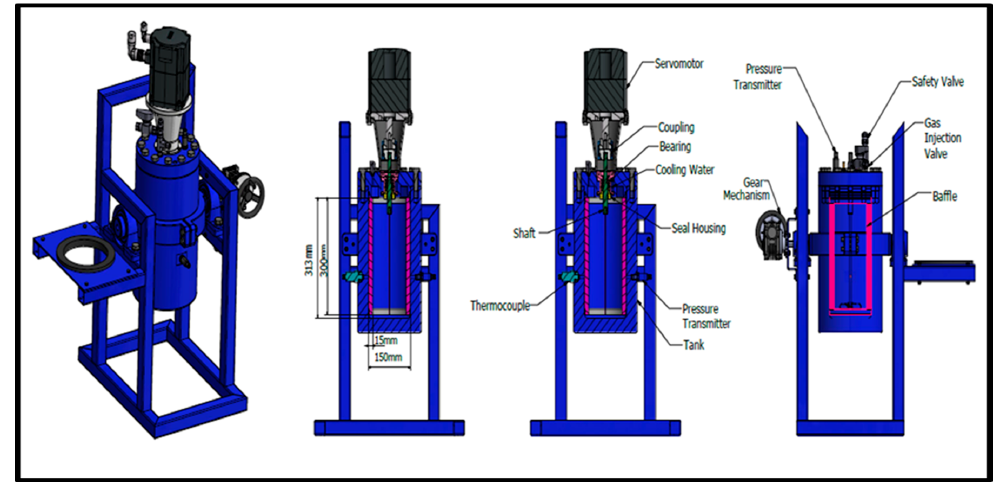
Figure 2. Cross-sectional design of reactor .